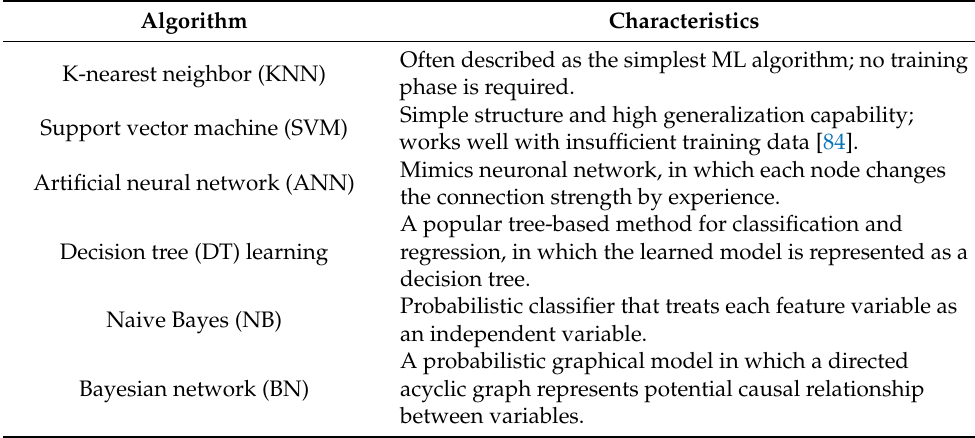
Table 2. Representative machine learning algorithms used in precision oncology. Algorithm